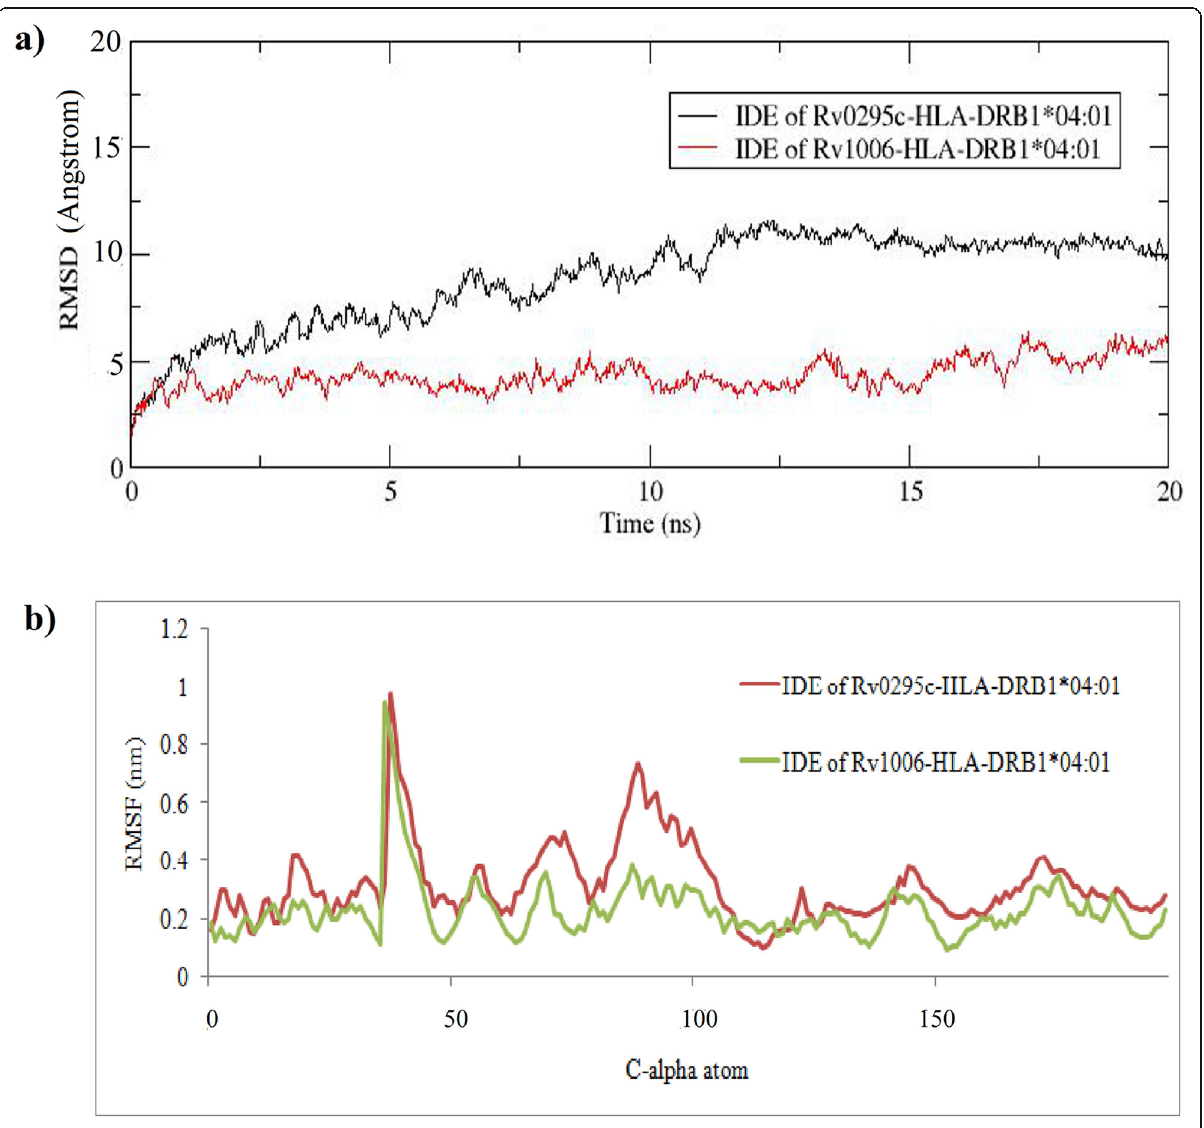
Fig. 3 Molecular dynamics studies. a RMSD graph of HLA-DRB1*04:01 in Rv0295c-HLA-DRB1*04:01 and in Rv1006-HLA-DRB1*04:01 complexes. b RMSF plot of HLA-DRB1*04:01 in Rv0295c-HLA-DRB1*04:01 and in Rv1006-HLA-DRB1*04:01